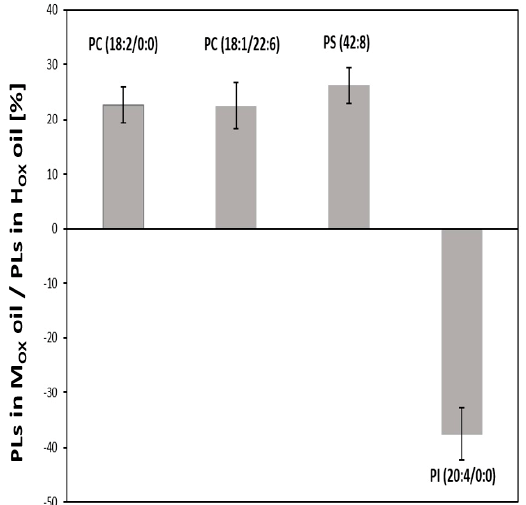
Figure 5. Upregulation of phospholipids (PLs) (%) in the human gastric tumor cells (HGT-1) after incubation with the undigested polar fraction of the M OX grape seed oil in relation to the undigested polar fraction of the H OX grape seed oil (M OX /H OX ).